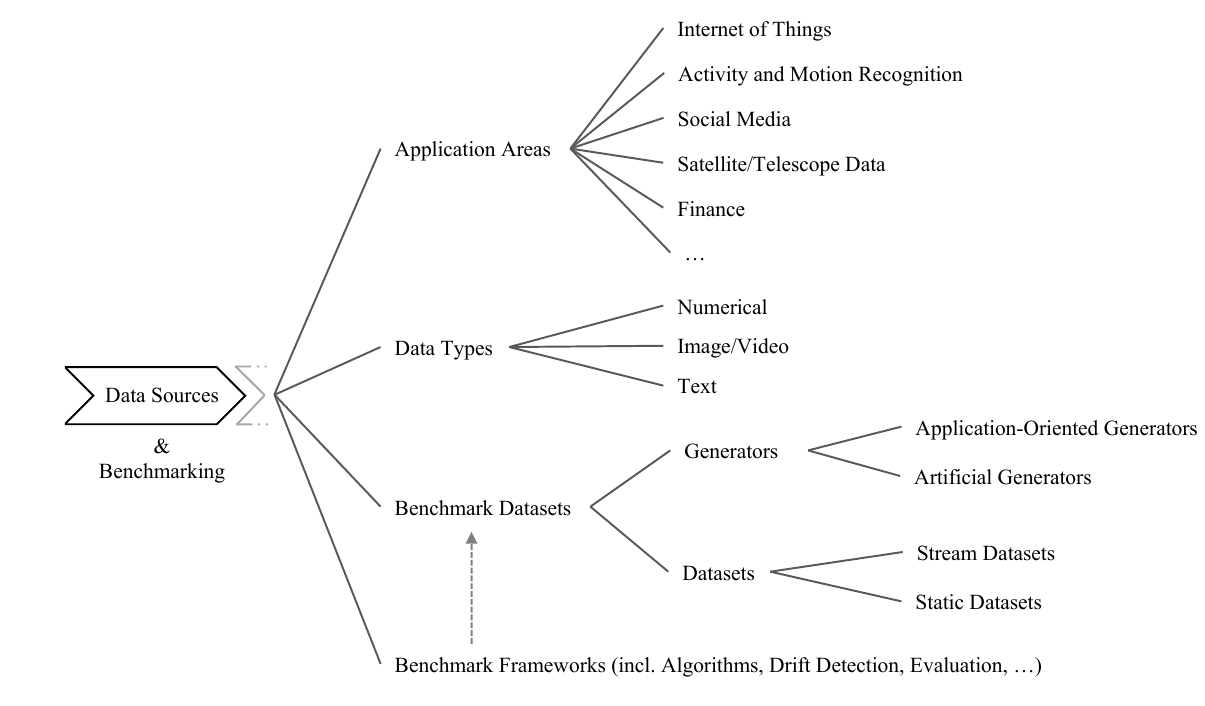
Figure 2. Typical application areas and data types, as well as a categorization of benchmarking datasets and frameworks, stand at the beginning of a stream classification